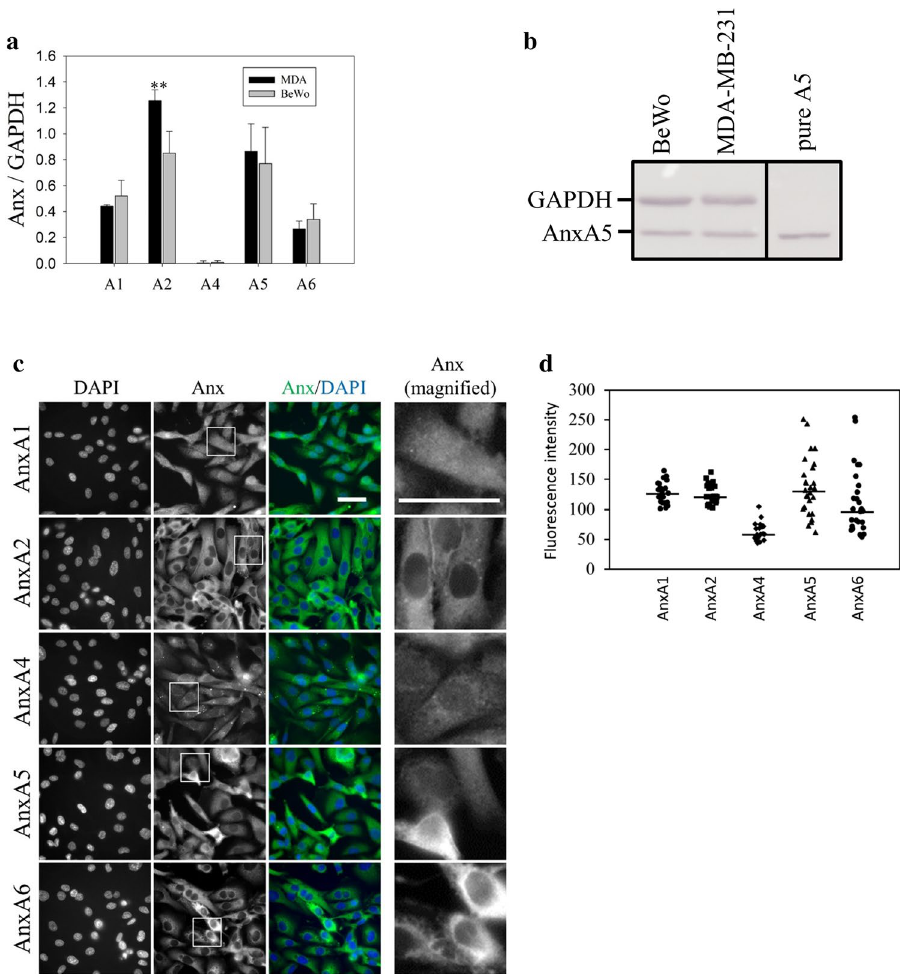
Figure 5. Expression and subcellular localization of endogenous Anx in MDA-MB-231. ( a ) 10 µg of protein extracts from MDA-MB-231 and BeWo cells were analyzed by western-blot. The gel analysis plugin of ImageJ was used to quantify the density of bands. The histogram presents mean values (± SD) of the ratio Anx/GAPDH from ten independent experiments. Student t Test for independent samples. ** p < 0.01. ( b ) Revelation of AnxA5 in MDA-MB-231 and BeWo cells compared to 50 ng purified recombinant AnxA5 (Pure A5), presented as an example. The whole membrane, together with representative western-blot analysis for AnxA1, A2, A4 and A6, are presented in Supplementary Fig. 2. ( c ) MDA-MB-231 cells were immunostained for AnxA1, AnxA2, AnxA4, AnxA5 and AnxA6 (green), as indicated, and counterstained with DAPI (blue). The right-hand column presents magnified images extracted from the “Anx” column (indicated by inserts). Scale bar: 40 µm. ( d ) Quantification of fluorescence intensities after immunostaining of endogenous Anx in MDA-MB-231